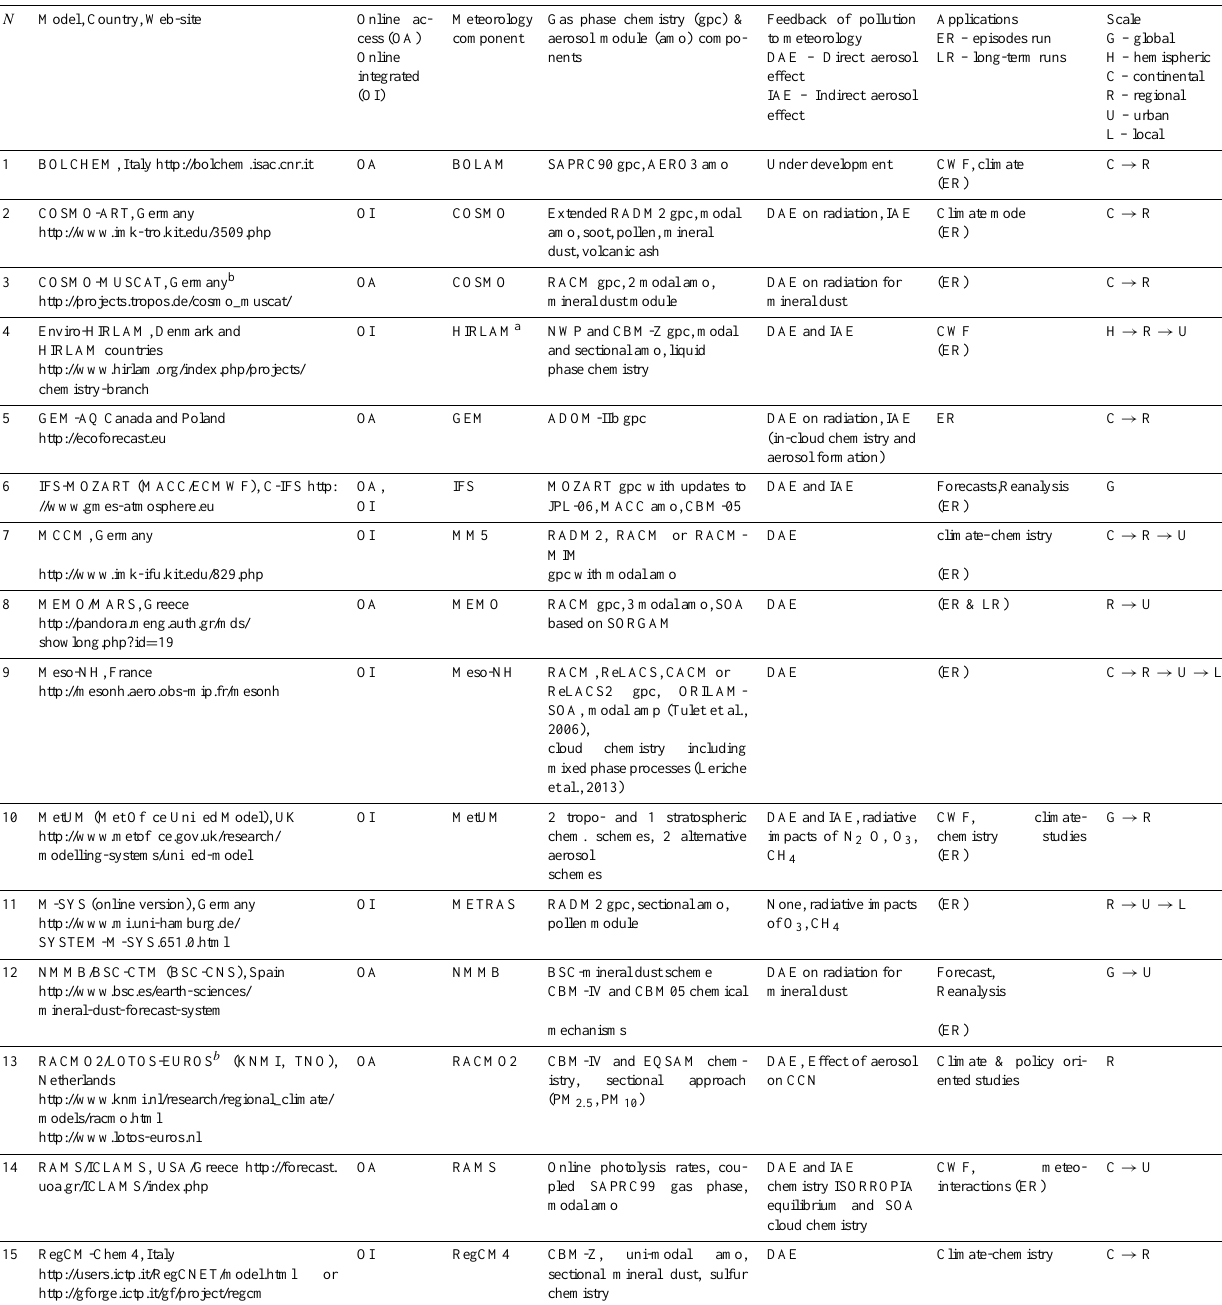
Table 4. Online integrated or online access Meteorology Chemistry models developed or applied in Europe. Typical grid-sizes are from 1km to